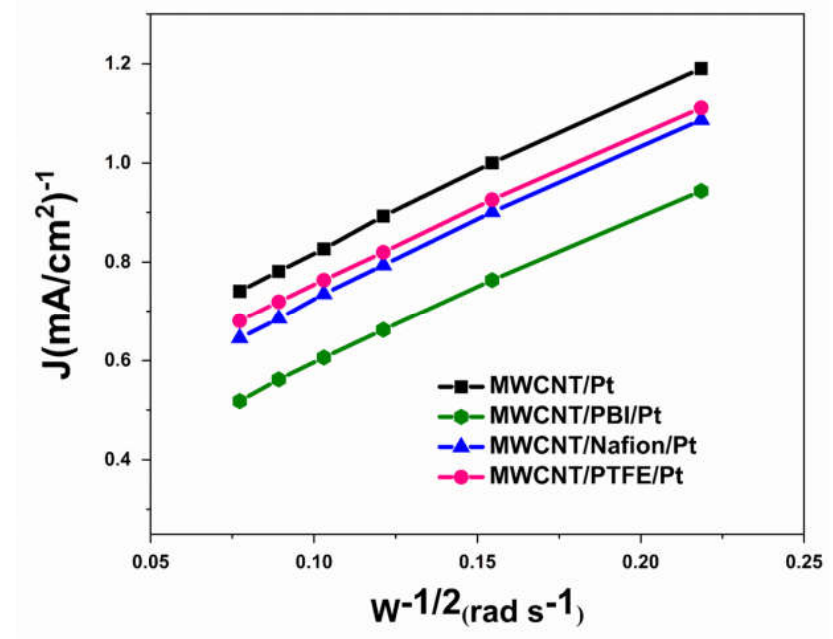
Figure 6. Koutecky–Levich plots of various electrodes.